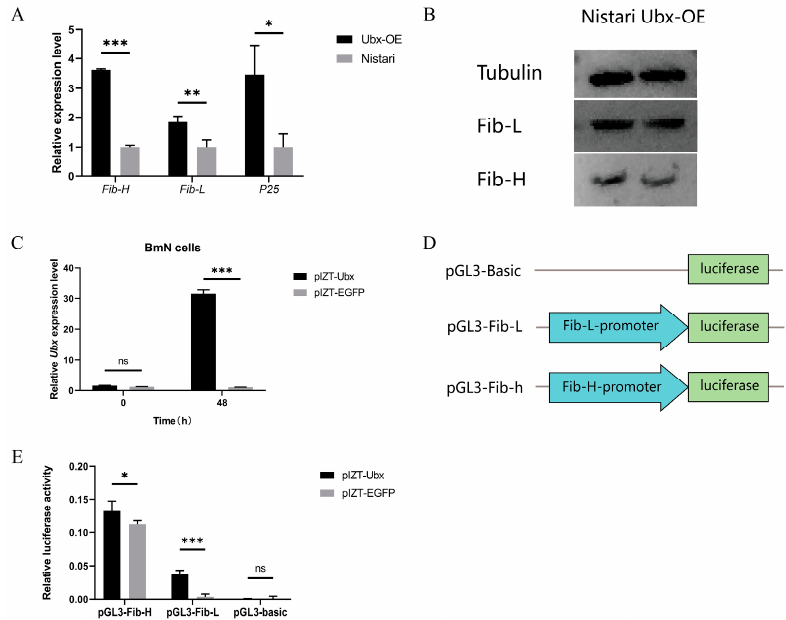
Figure 4. Activation effect of promoter of fibroin genes by Ubx. ( A ) The expression of fibroin genes in Ubx OE and Nistari. Fib-H means fibroin heavy chain and Fib-L means fibroin light chain . ( B ) Western-blot result of Fib-L and Fib-H in the PSG of third-day fifth-instar larva of Ubx OE and Nistari. ( C ) Overexpression of Ubx in BmN cells. The expression of Ubx was significantly enhanced by pIZT-Ubx at 48 h after transfection. The pIZT-EGFP was used as a negative control. ( D ) Design of reporter plasmids in dual luciferase reporter assay. ( E ) Promoter activity of Fib-L and Fib-H after overexpressing Ubx in BmN cells. Ubx-OE, the transgenic strain with Ultrabithorax overexpressed, namely Ubx OE . Nistari, the control of Ubx OE . pIZT-Ubx, BmN cells transfected with plasmid of pIZT-mCherry-V5-his-Ubx, overexpressed Ultrabithorax . pIZT-EGFP, BmN cells transfected with plasmid of pIZT-mCherry-V5-his-EGFP, was the negative control of pIZT-Ubx. Error bars indicate the standard error of the mean ( n = 3). Significant differences were assessed using Student’s t -test (ns p > 0.05, * p < 0.05, ** p < 0.01, and *** p < 0.001).